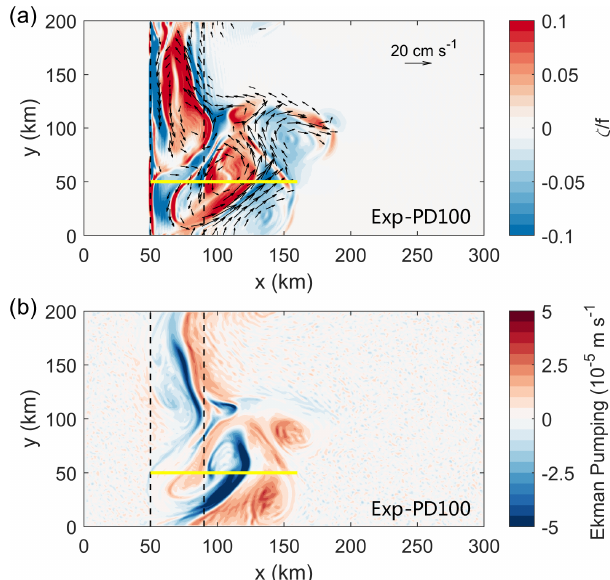
Figure 13. Distributions of (a) the surface-normalized relative vor- ticity ζ/f and velocity vectors faster than 5cms − 1 as well as (b) ice-induced Ekman pumping at t = 101d from Exp-PD100. The yellow line marks a cross-channel section spanning x = 50 to 110km at y =